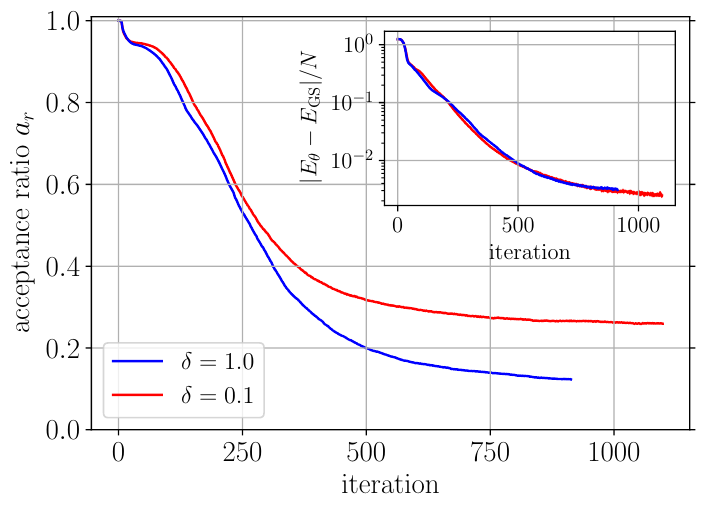
Figure 16: MC acceptance ratio a during optimization for global MC proposals and r mixed local-global MC proposals for δ = 0.1 (see text). Inset: the corresponding energy training curves. The parameters are the same as in Fig. 7. The system size is / J = 0.5. Optimiza- N = 6 × 6. The network architecture is listed in App. H, and J 2 1 tion was done using RK in combination with SR, see App. A. The MC sample size is = 2 15 N MC